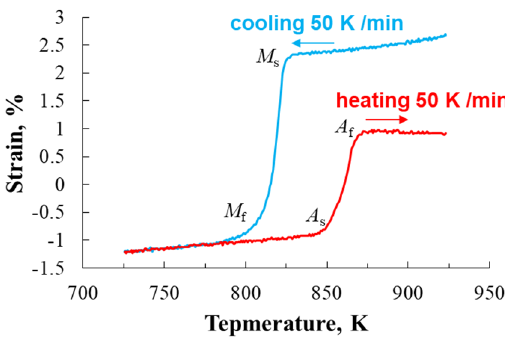
Figure 4. Strain-Temperature curves of equiatomic TiPd alloy. The applied stress is 50 Figure 4. Strain ‐ Temperature curves of equiatomic TiPd alloy. The applied stress is 50 MPa.